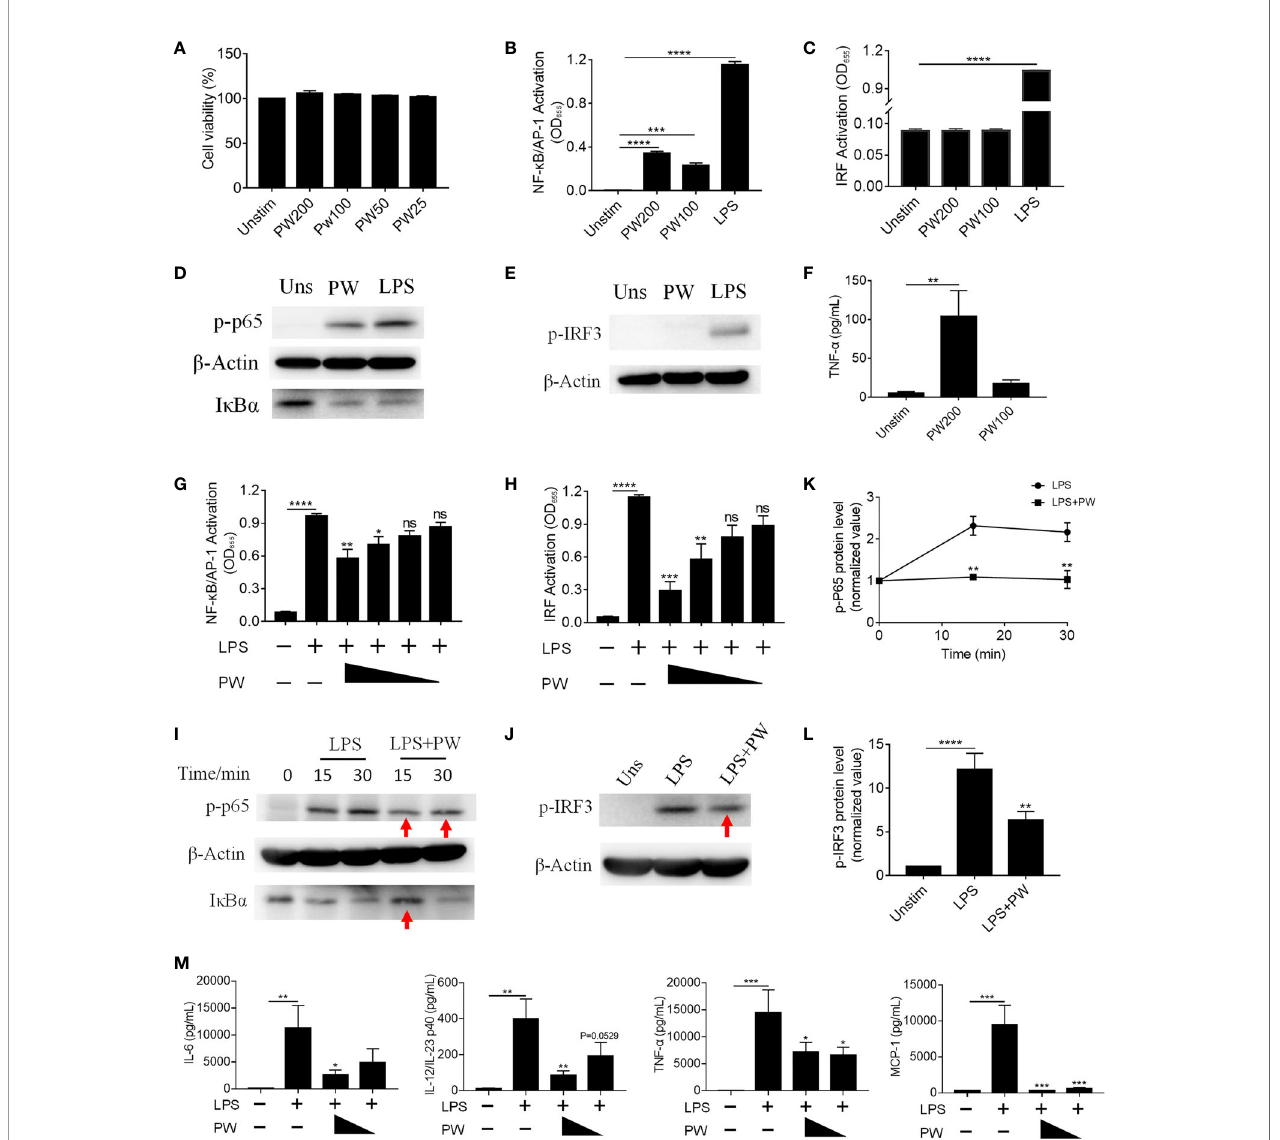
FIGURE 2 | The immunomodulatory activity of PW on TLR4 signaling in THP-1-derived macrophages. (A) The effect of the PW treatment on the cell viability measured by the MTS assay; PW concentrations: 200, 100, 50 and 25 nM. (B, C) The effect of PW treatment alone on the activation of NF- k B/AP-1 (B) and IRF (C) in the THP-1 reporter cell-derived macrophages. (D, E) Immunoblotting validating the effect of PW (200 nM) on the phosphorylation of p65 (p-p65) and degradation of I k B a at 1 h for NF- k B activation (D) and the phosphorylation of IRF3 (p-IRF3) at 1 h for IRF activation (E) in THP-1-derived macrophages; b -actin as the internal control. (F) TNF- a production induced by PW at 100 and 200 nM. (G, H) The inhibition of LPS-induced activation of NF- k B/AP-1 (G) and IRF (H) by PW with various concentrations (200, 100, 50 and 25 nM) in the THP-1 reporter cell-derived macrophages. (I, J) Immunoblotting con fi rming the inhibitory effect of PW (200 nM) on the LPS-induced phosphorylation of p65 (p-p65) and degradation of I k B a for NF- k B activation (I) and the phosphorylation of IRF3 (p-IRF3) at 1 h for IRF activation (J) ; b -actin as the internal control; the time course of p65 phosphorylation (K) and the IRF3 phosphorylation (L) were quanti fi ed from (I) and (J) , respectively. (M) Inhibition of IL-6, IL-12/IL-23p40, TNF- a and MCP-1 production upon 24 h LPS stimulation by PW (200 and 100 nM) in THP-1-derived macrophages. N ≥ 3, LPS = 10 ng/mL, ns, not signi fi cant, *p < 0.05, **p < 0.01, ***p < 0.001, ****p < 0.0001 vs .